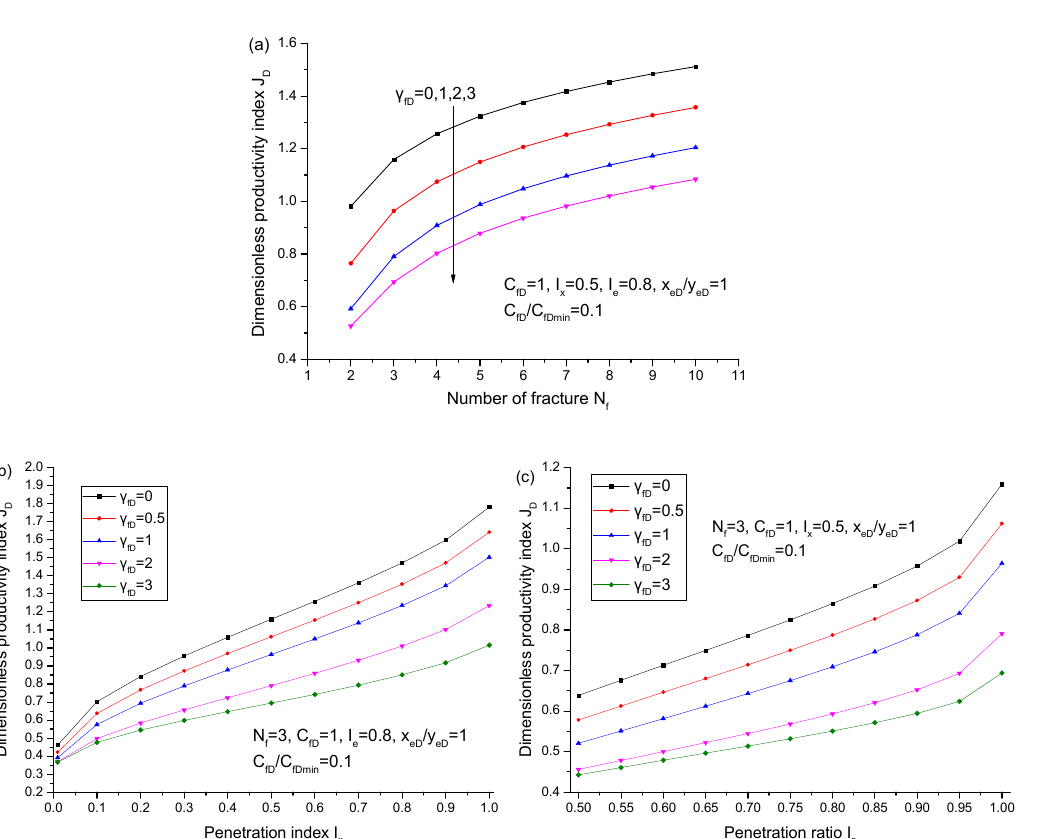
Figure 16. Influence of dimensions of the fracture on PI behavior in the consideration of pressure sensitivity, including ( a ) number of fracture, ( b ) penetration index of fracture, and ( c ) penetration of horizontal wellbore.